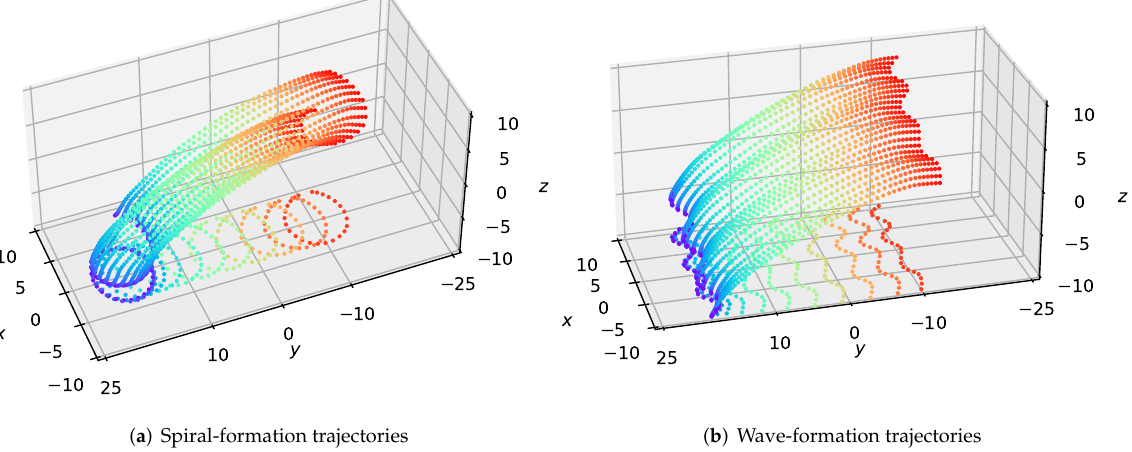
Figure 3. The visualization of the executed trajectories for the formation flight of large-scale UAVs. The xoy -plane projections represent the outline of the